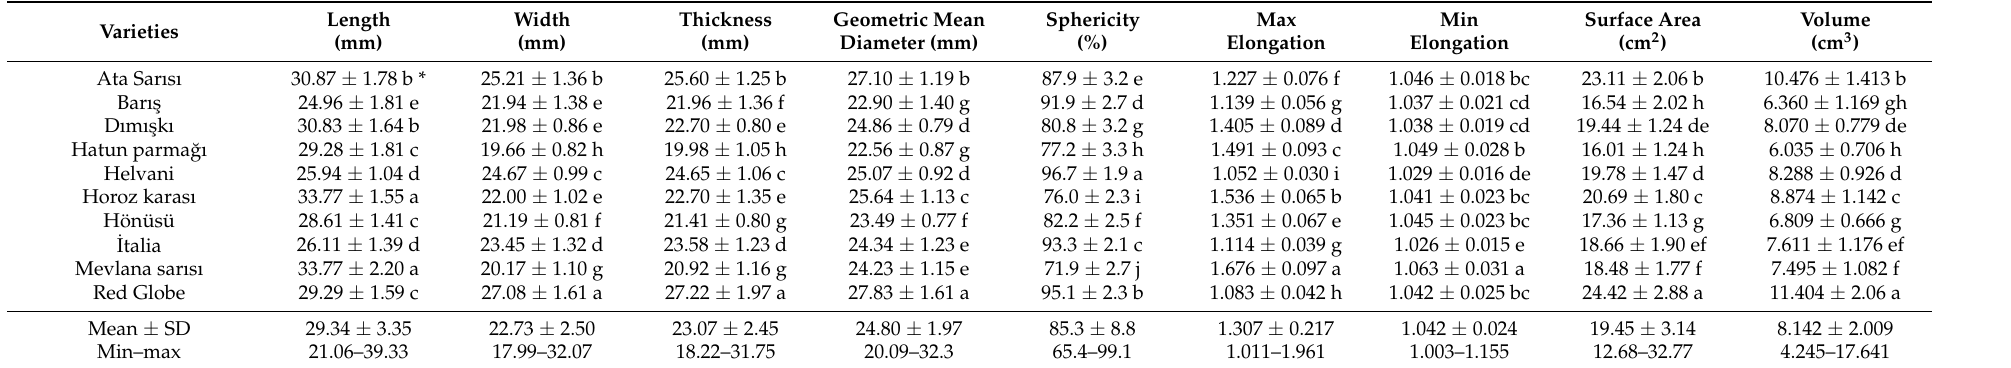
Table 3. Characteristic size and shape traits of the grape